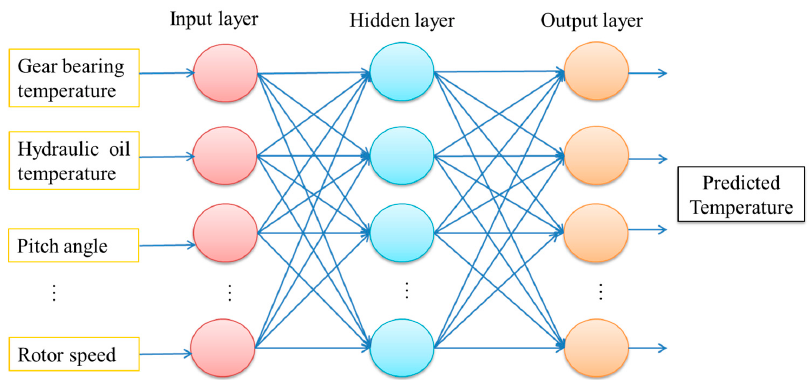
Figure 6. The architecture of the three-layer BPNN.